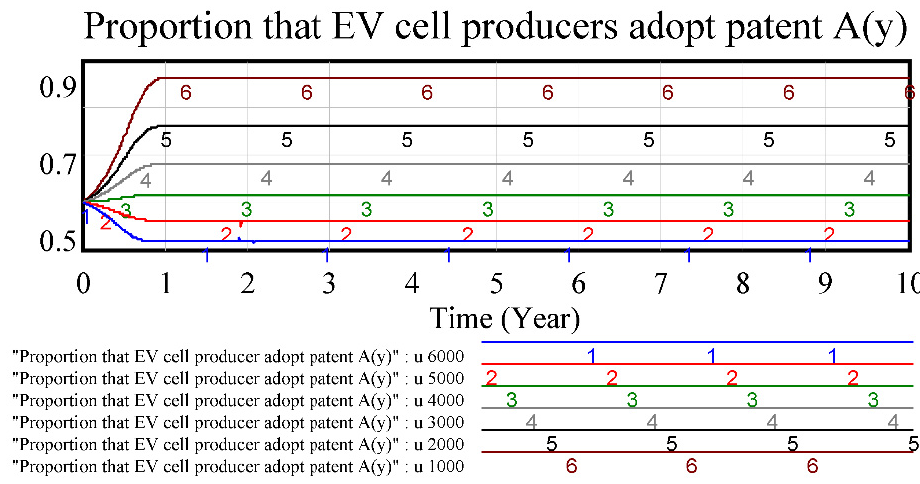
Figure 4. Sensitivity test of factor u that impacts EV cell producer.